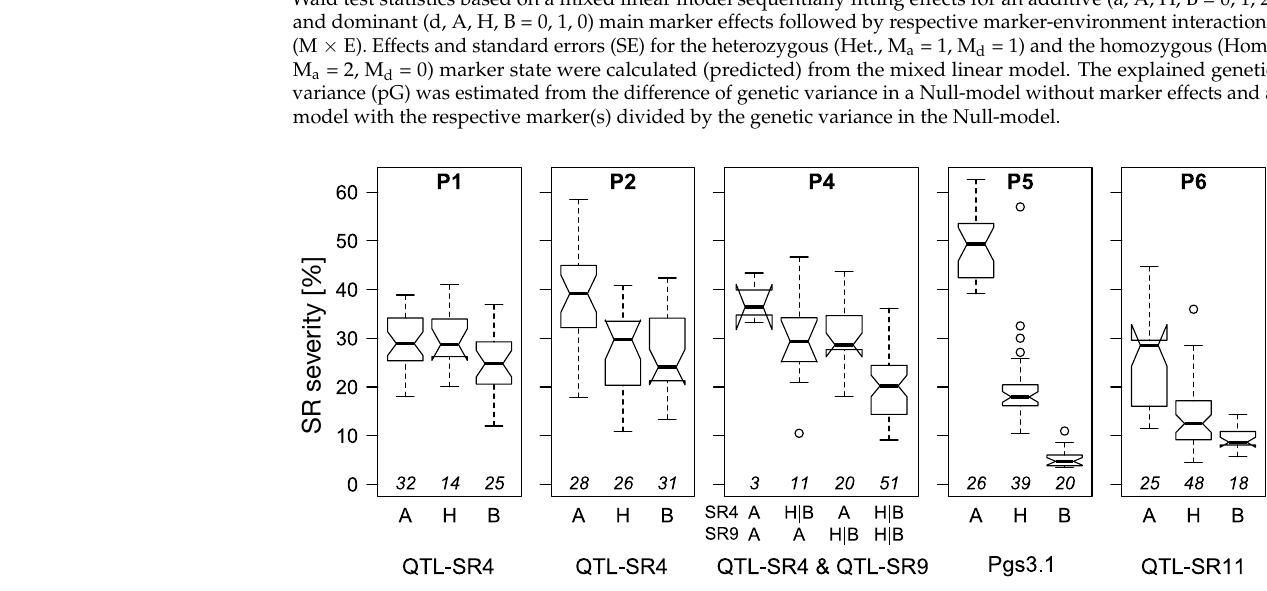
Figure 4. Visualisation of population-wise marker effects of selected stem rust QTLs and Pgs3.1 . For each population (separate plot), the genotypes were grouped by marker alleles of the associated marker from the respective QTLs/gene and adjusted means across environments were visualized as boxplots. The respective number of genotypes is reported in italics above the bottom line. For P4, the combination of two markers is displayed. For display reasons and for both markers, genotypes with heterozygous allele and homozygous allele B were combined into one group